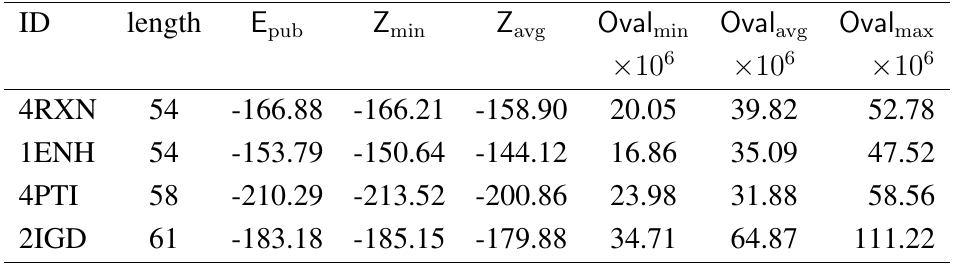
Table 7. Results for the energy pairwise interactions energy function from [32] on 3D FCC lattice for the benchmarks from Table 3. E are the published results from pub